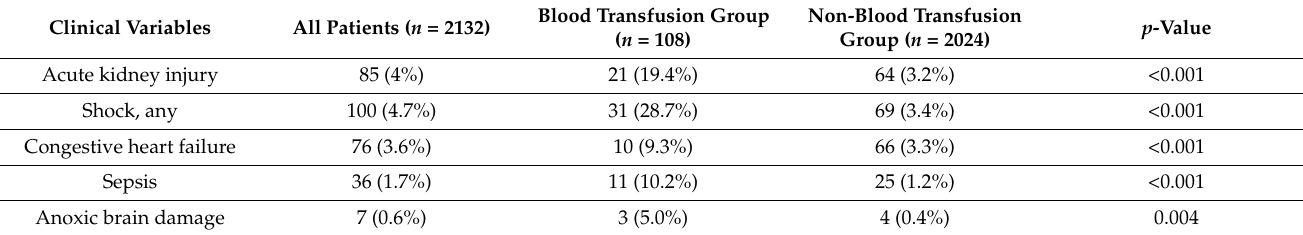
Table 4. Blood transfusion rate according to in-hospital complications.